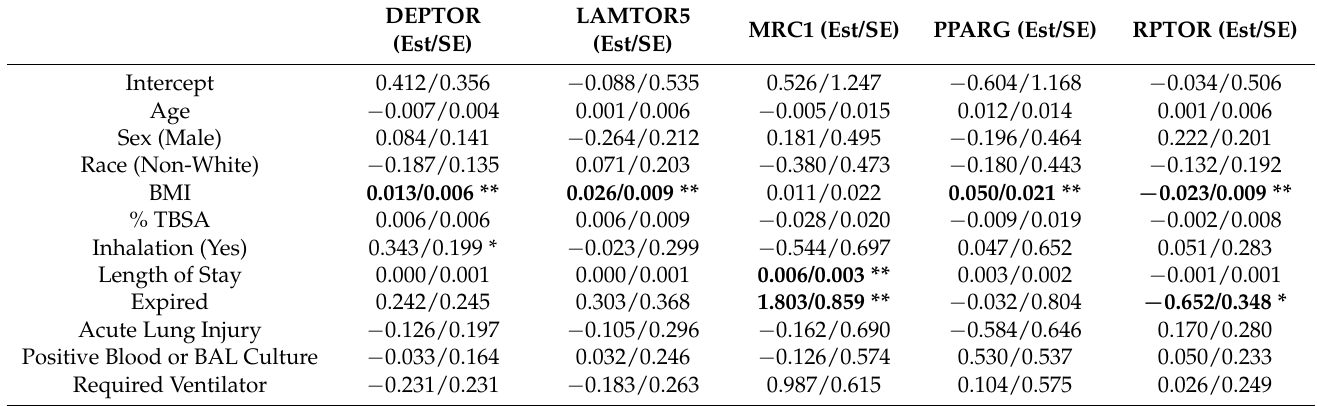
Table 2. Linear regression modeling parameter estimates, standard error and p -values for